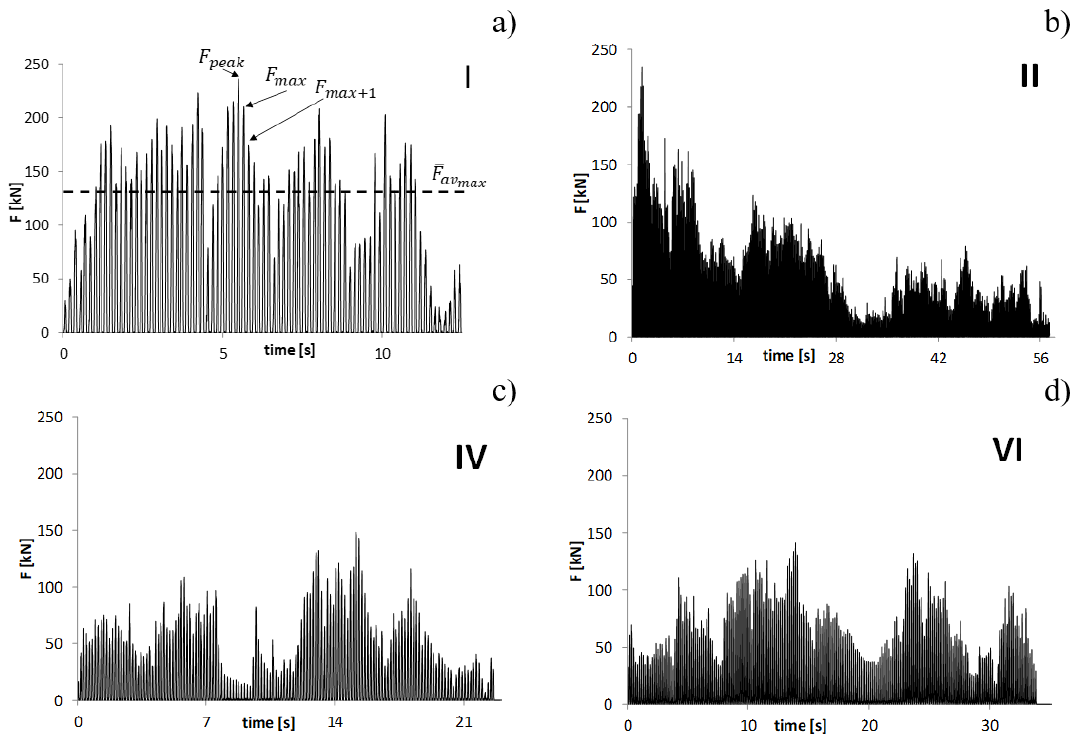
Figure 13: Diagrams of force F in toggle plate as a function of time for the entire attempt: a) flat plates-set I, b) triangular profile plates and coaxial arrangement of teeth – set II, c) variable pitch, height and coaxial arrangement of teeth – set IV, d) variable width, pitch and coaxial set of teeth – set